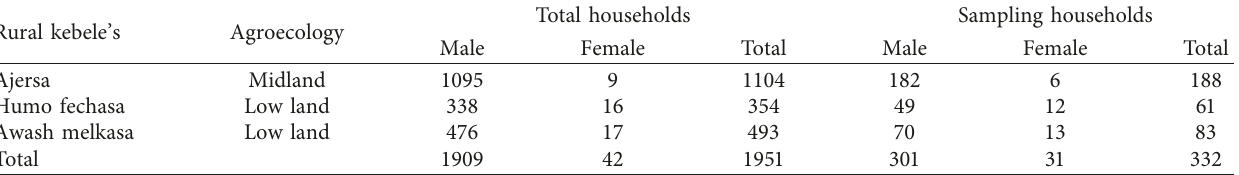
Table 1: A sample of households from the selected